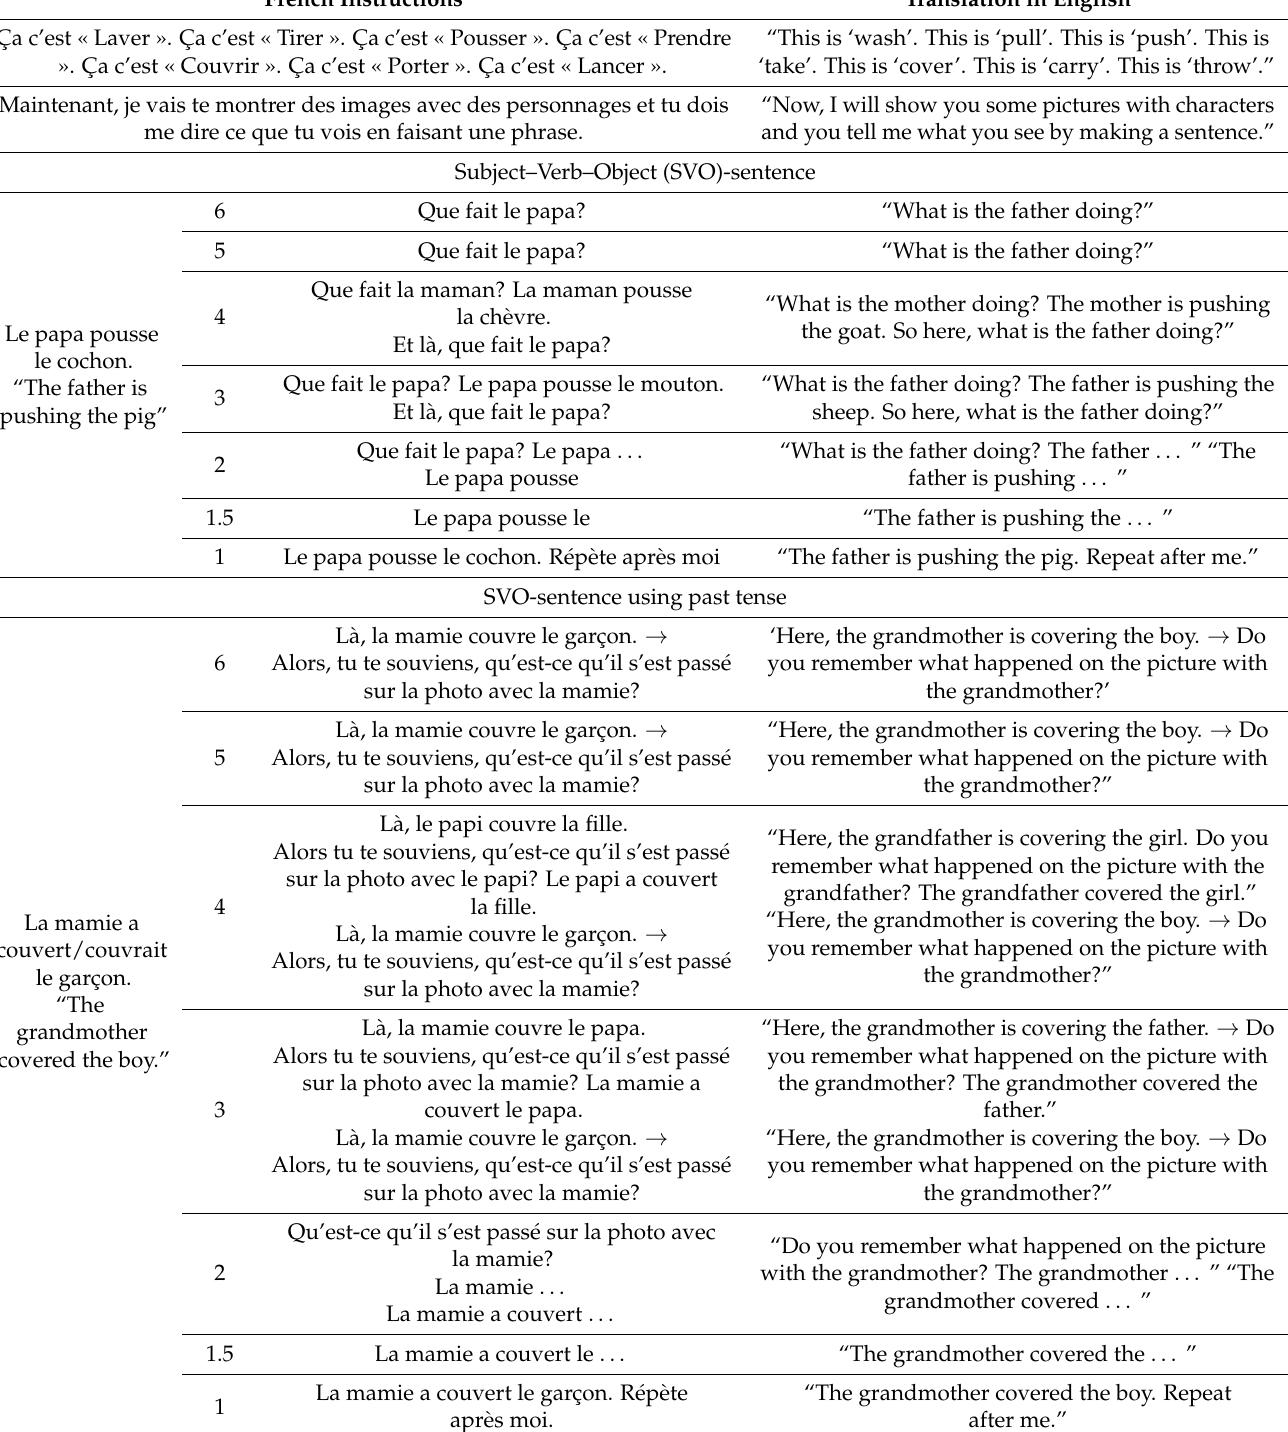
Table A1. An example of one of the three items, for each targeted